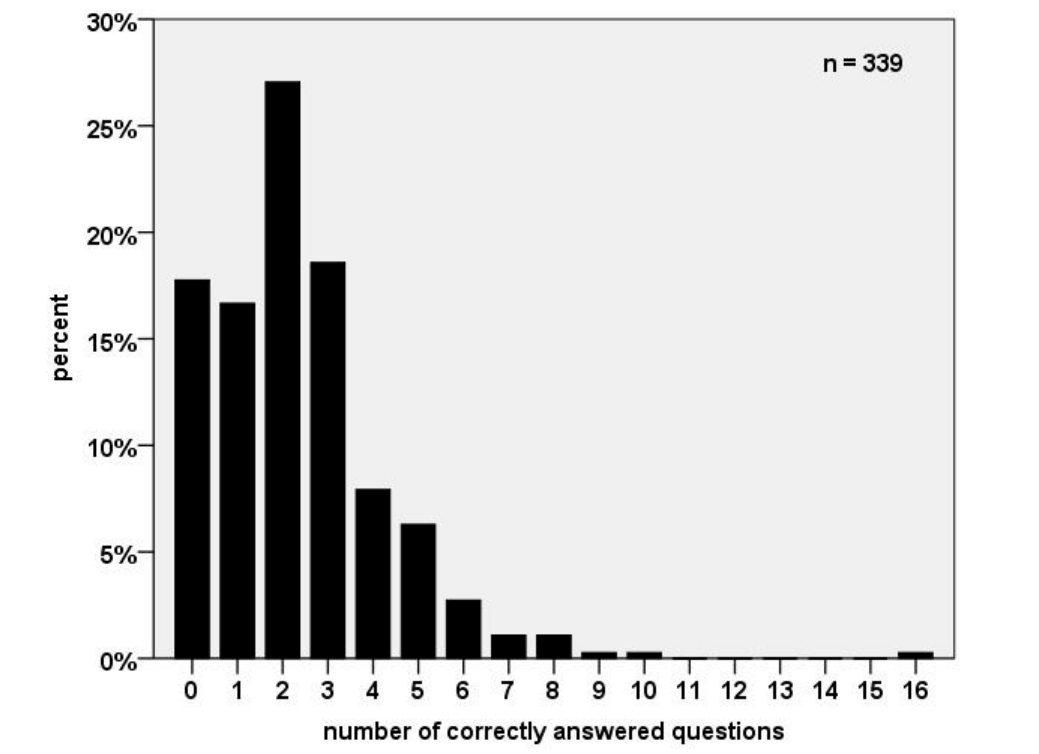
Figure 2. Number of correctly answered first aid questions.